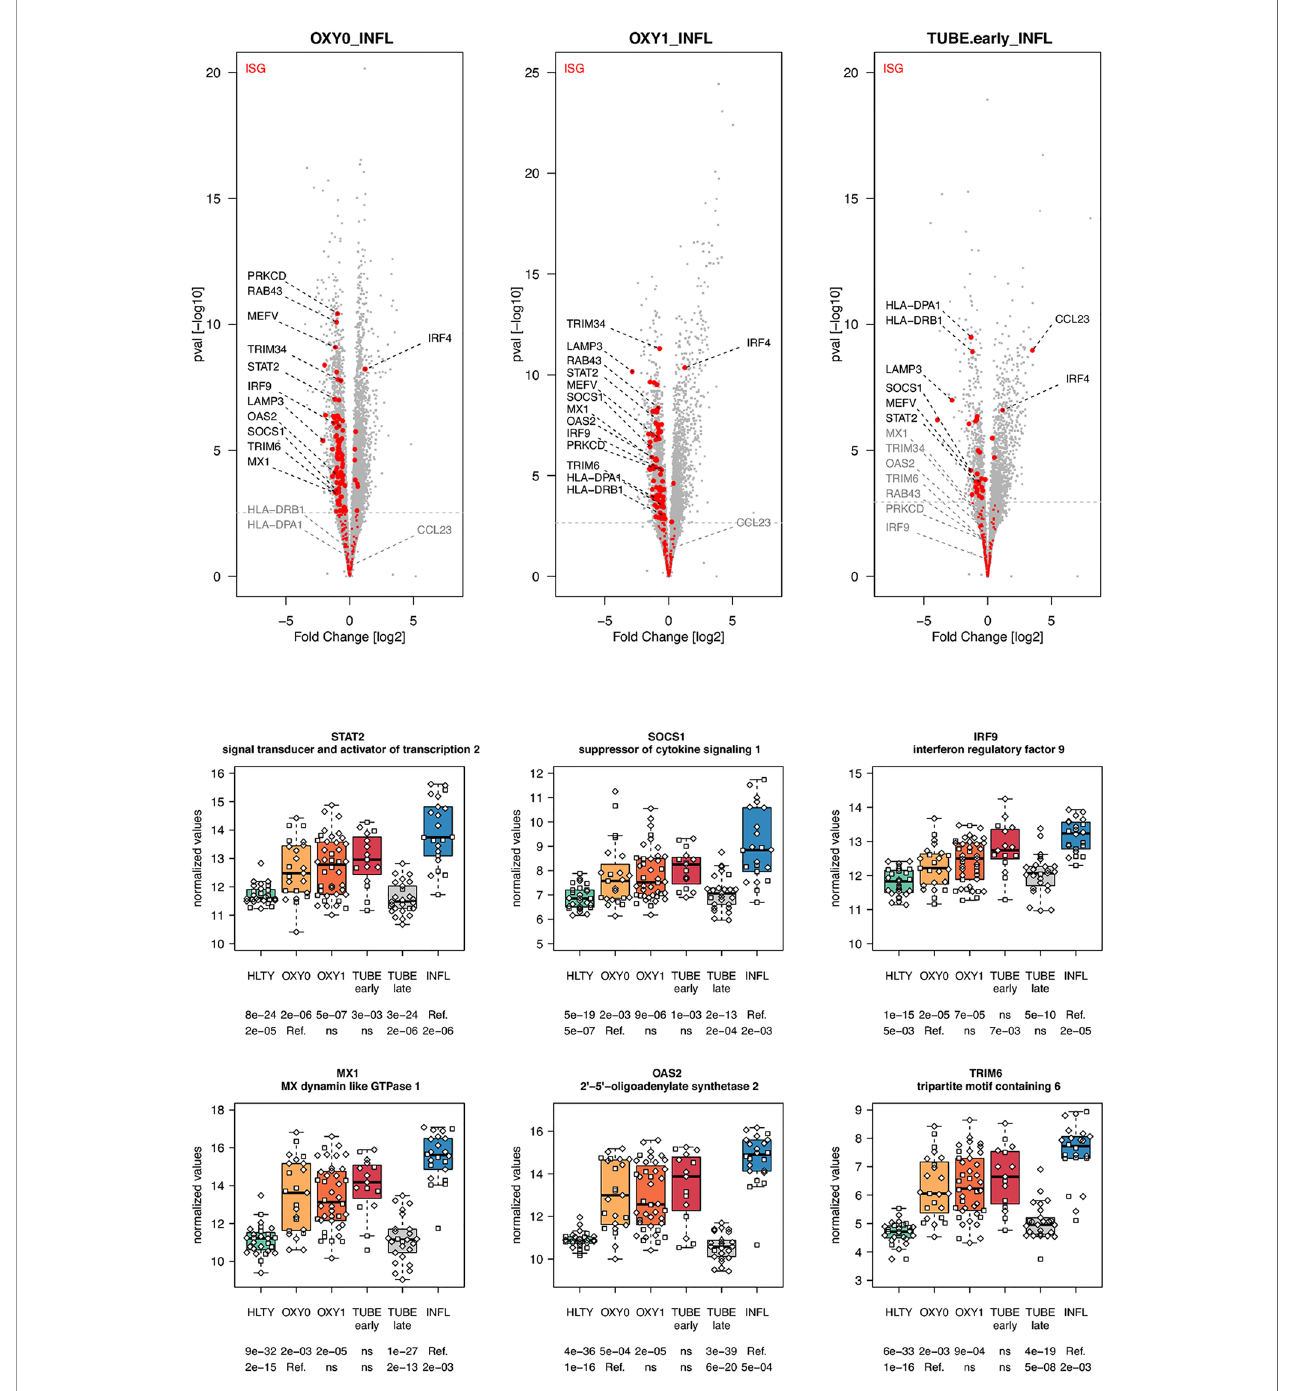
FIGURE 4 | Differentially expressed interferon-stimulated genes. Upper panel: for each comparison indicated in the volcano plot header, the distribution of log2 fold changes and P-values of all detected genes is shown as gray dots. Red dots indicate genes included in the ISGs (interferon-stimulated genes) gene set. Genes ’ sets are selected from different GO, REACTOME and/or KEGG pathways (see Supplementary Table 2 ). The dotted horizontal gray line indicates the limit under which – log10(P-value) becomes non signi fi cant once adjusted for multiple testing (adjusted P > 0.01). Lower panel shows detailed expression levels of selected genes involved in IFN signal transduction and IFN stimulated genes in the different groups of patients. Groups used for comparisons include SARS-Cov-2 infected patients (no oxygen support [OXY0], oxygen support [OXY1], intubation with sampling within 7 days [TUBE early] or >7 days [TUBE late] after hospital admission), In fl uenza virus [INFL] infected patients and non-infected controls [HLTY]. Adjusted P-values of pairwise comparisons between a reference group (Ref.) and another group are indicated below the x axis. Ref. is taken as [INFL] and [OXY0] on the fi rst and second line,